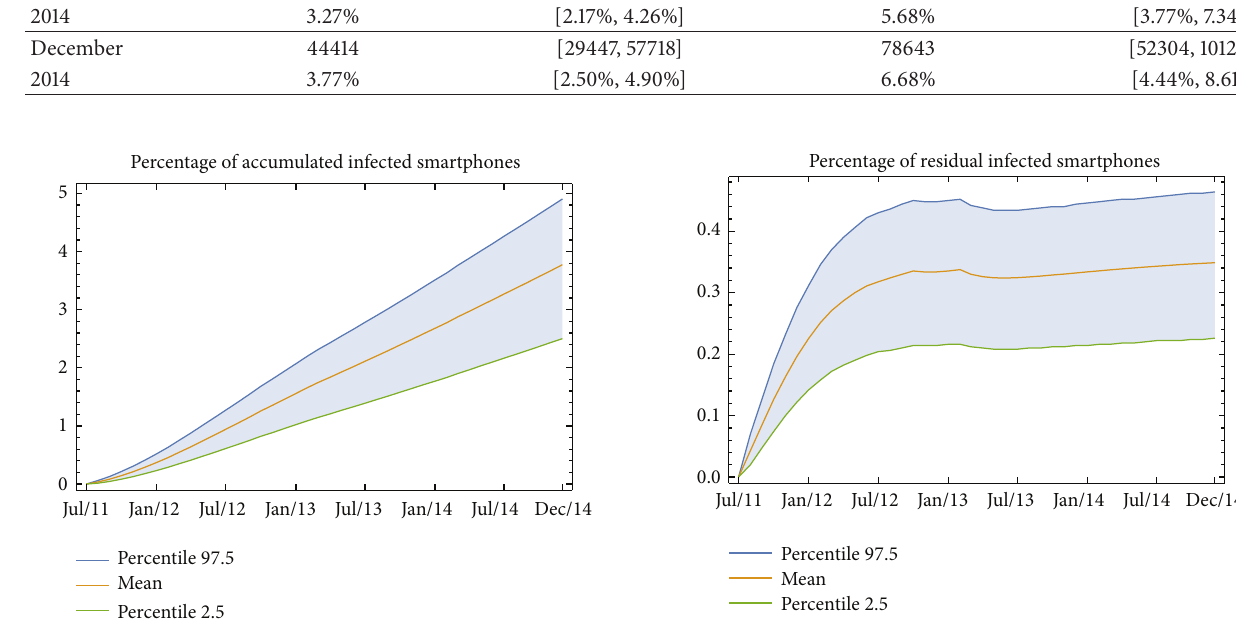
Figure 4: Evolution of new smartphone infections every month since July 2011 until December 2014. The line in the middle is the mean and those up and down correspond to 95% confidence interval. Nowadays, there is a stabilization in the number of new infected